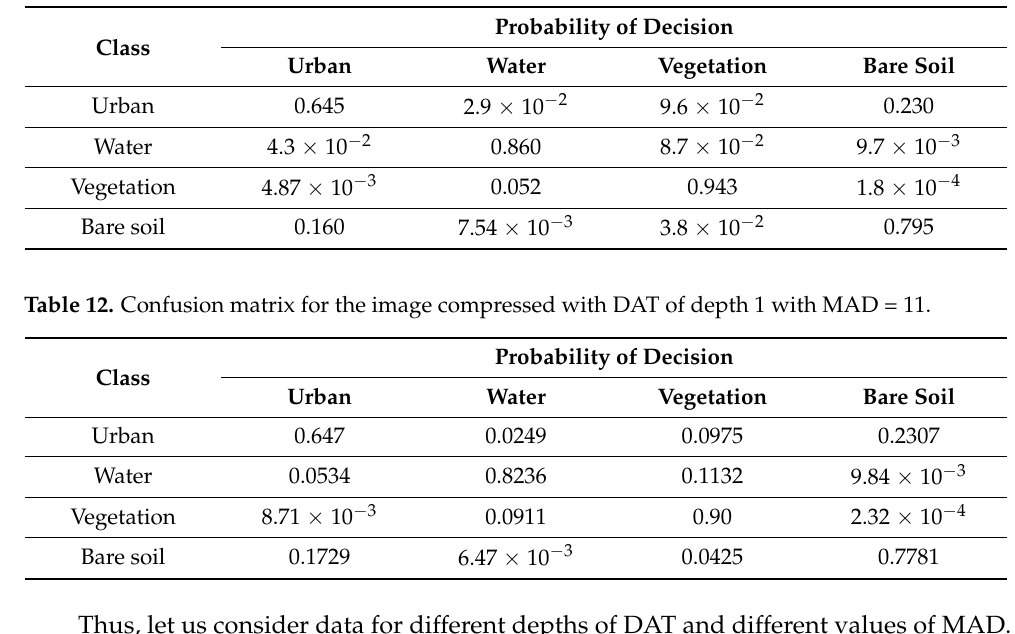
Table 11. Confusion matrix for original image in Figure 12b.